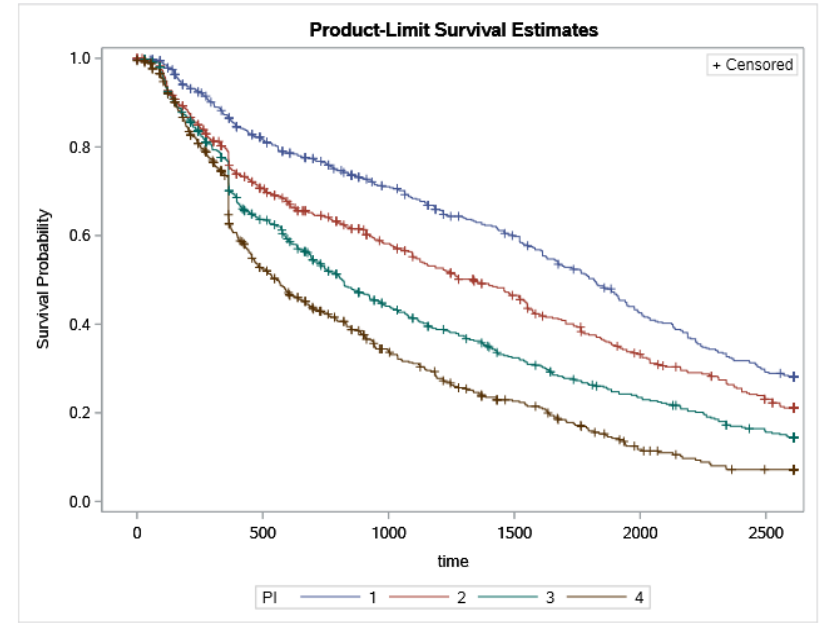
Figure 3. Product-Limit Survival Curves.